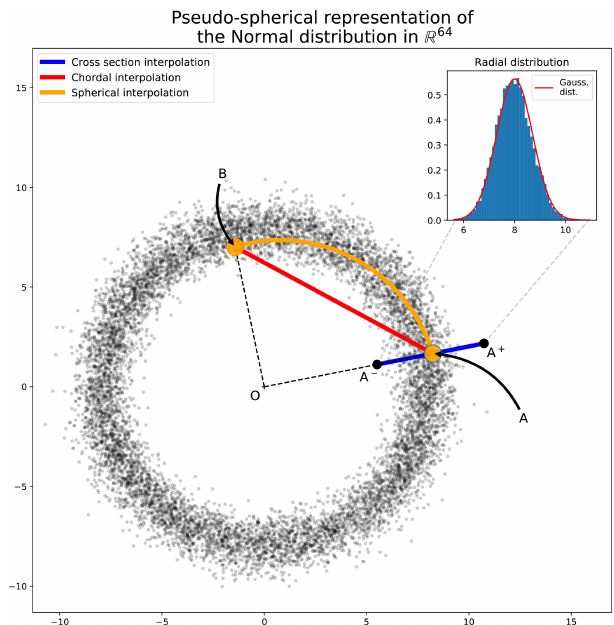
Figure 24. Pseudo-spherical metaphorical representation of 10000 samples of the normal distribution in R m with m = 64 and the dis- tribution of the distance of samples to the center of the spherical shell. For a sample A , A ± denotes two extreme situations along the direction of A . Any second sample B , typical of the distribution, appears orthogonal to A . The inset figure represents the radial dis- tribution compared with the asymptotic central limit theorem (CLT) √ m, 1 ) (thin red curve). Gaussian distribution N ( 2